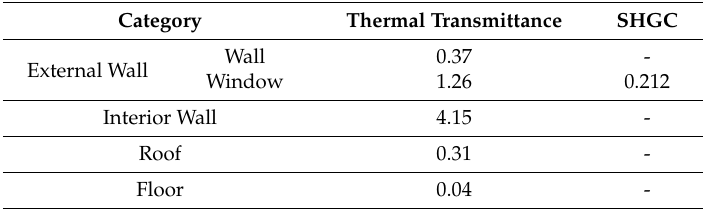
Table 3. Material property of the target